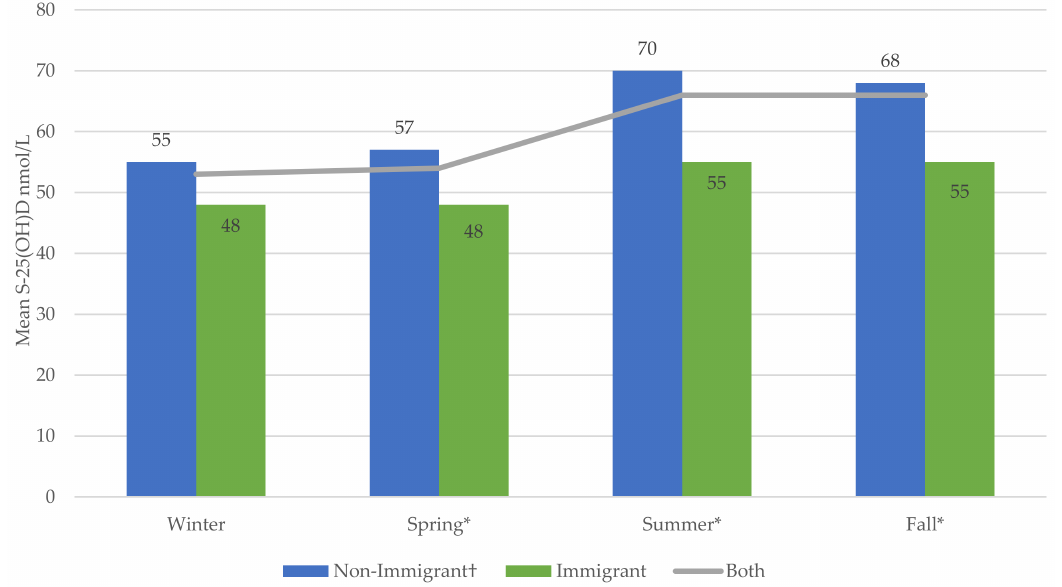
Figure 2. Weighted seasonal variation in mean S-25(OH)D (nmol/L) based on immigration status using Cycles 3 and 4 of Canadian Health Measures Survey data († reference value * significant at p ≤